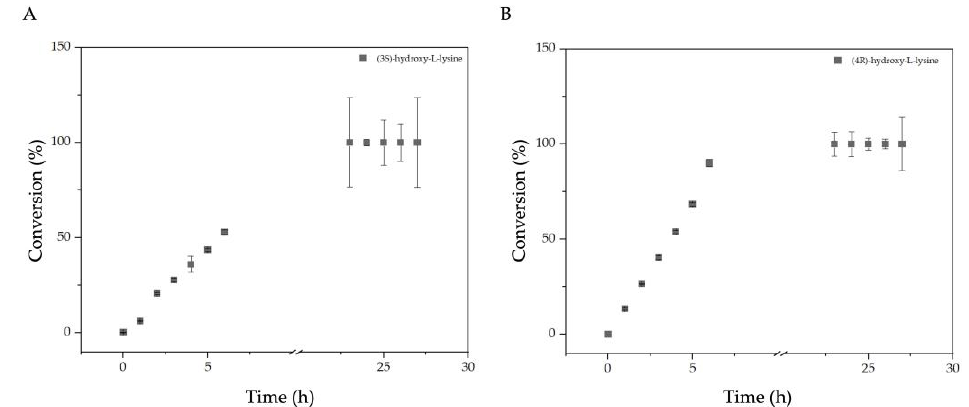
Figure 6. Conversion curves for the synthesis of (3 S )-hydroxy-L-lysine by Ca KDO ( A ) and (4 S )-hydroxy-L-lysine ( Fj KDO) ( B ), respectively. Reactions were performed in a 50 mL shaking flask without baffles in a reaction volume of 15 mL, ( A ) 1.3 mg mL − 1 immobilized Ca KDO-HaloTag ® , 20 ◦ C, and ( B ) 1.2 mg mL − 1 immobilized Fj KDO-HaloTag ® , 25 ◦ C. Reaction mixture: 100 mM L-lysine, 150 mM α -KG, 2.5 mM L-ascorbic acid, 0.01 mM DTT, and 1 mM (NH 4 ) 2 Fe(SO 4 ) 2 for 27 h, at 150 rpm orbital shaking. Error bars are the result of two independent immobilizations.